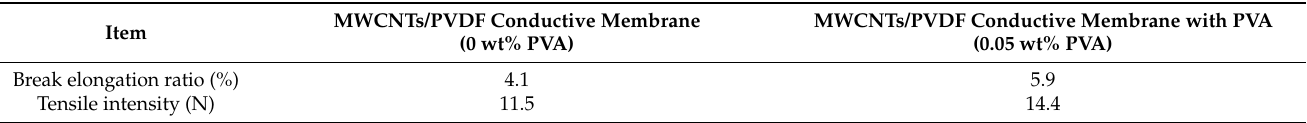
Table 1. Mechanical properties of membrane without and with the PVA.